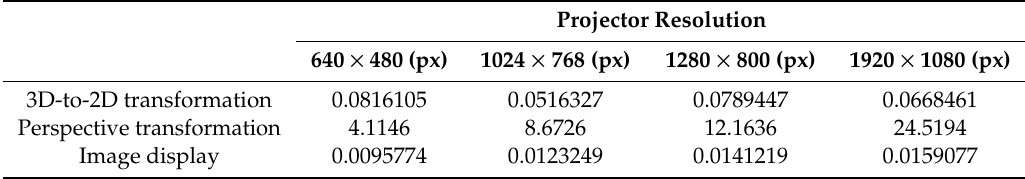
Table 3. Results of data processing times for dynamic video mapping of the box—Variant II.